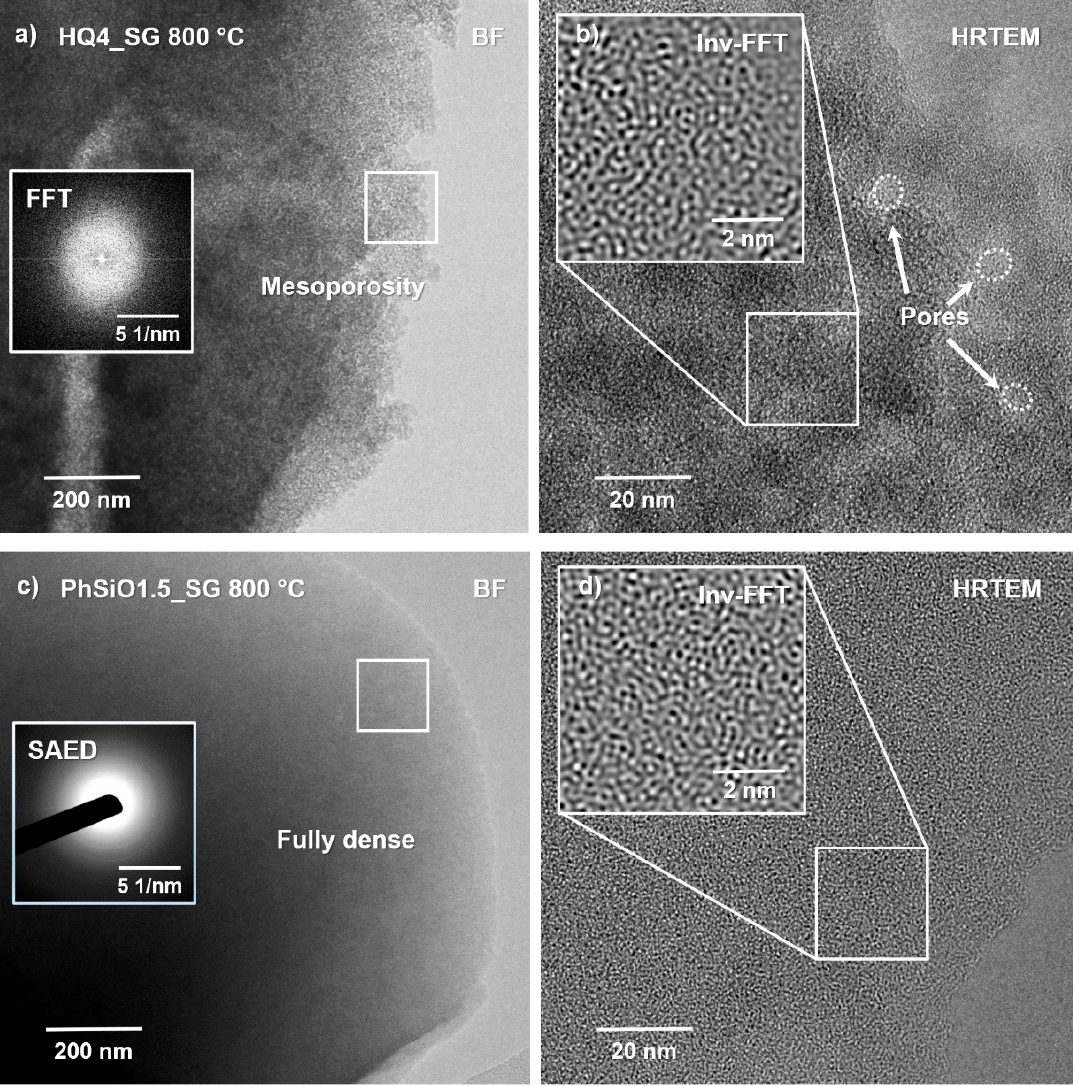
Figure 10. Bright-field (BF) and high-resolution transmission electron microscopy (HRTEM) images of ( a , b ) the HQ4_SG 800 °C sample, while in ( c , d ) the PhSiO 1.5 _SG 800 °C material is depicted. Both samples are fully amorphous, as can be seen from the FFT/SAED insets in ( a , c ) as well as from the inverse Fast-Fourier-Transform images (Inv-FFT) given in ( b , d ).